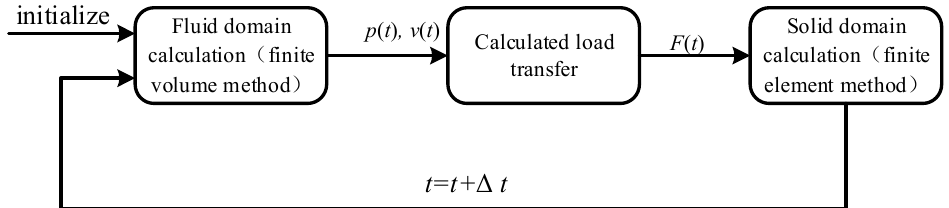
Figure 4. Solution Strategy of one-way fluid-structure interaction.